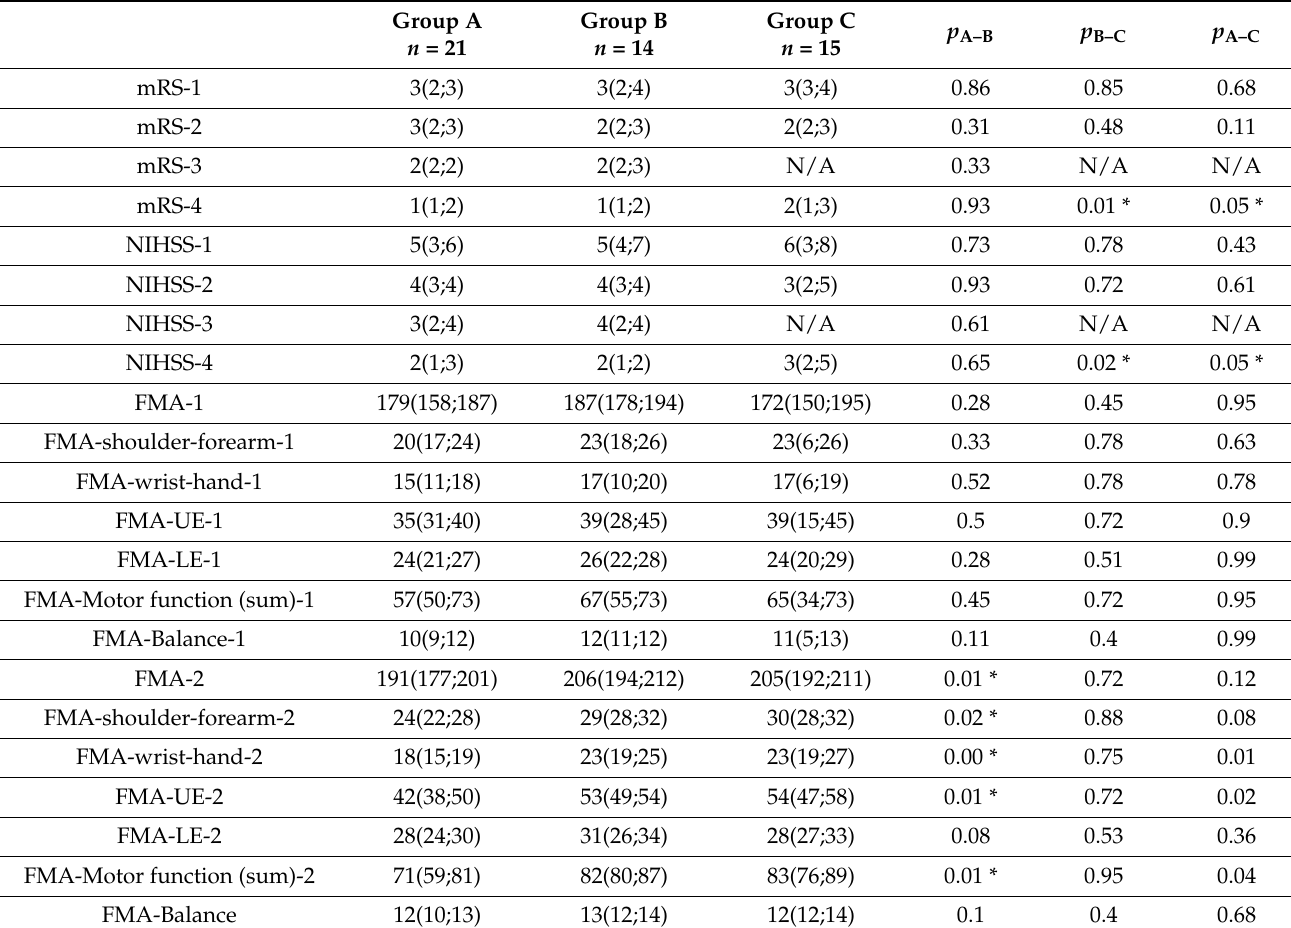
Table 2. Estimated mean differences between patients groups. Group